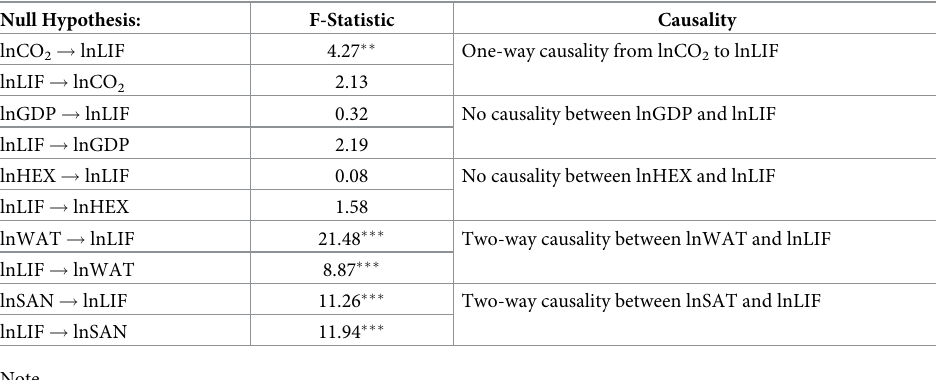
Table 6. Pairwise granger causality tests.